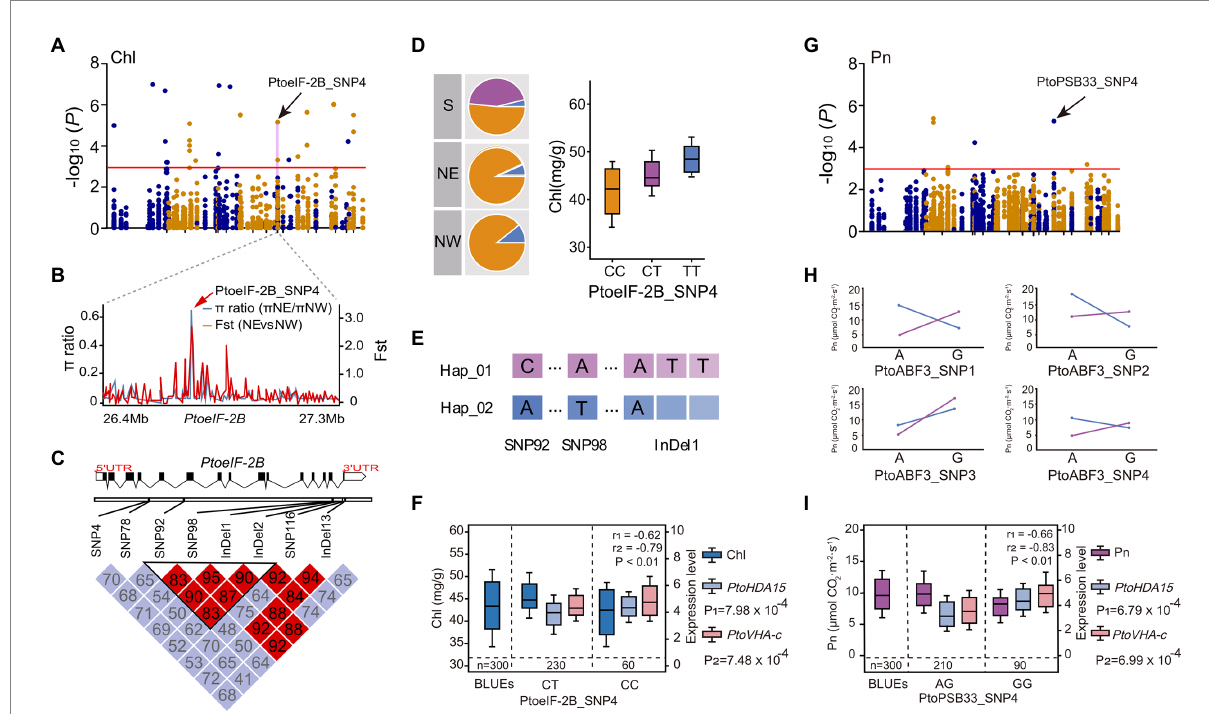
FIGURE 4 PtoPSB33 and PtoeIF-2B are implicated in the response to drought stress in P. tomentosa . (A) Manhattan plot for Chl. (B) Identification of the selection sweep signature of PtoeIF-2B_SNP4. (C) The genome structure and haplotype block of PtoeIF-2B gene. (D) Genotypic frequencies of significant SNP of PtoeIF-2B among the three regions. (E) Three significant loci detected by single-gene association analysis, which constituted a conserved haplotype. (F) Box plots for Chl (dark-blue), PtoHDA15 expression (blue) and PtoVHA-c expression (pink) plotted as an effect of genotype at PtoeIF-2B_SNP4. (G) Manhattan plot for Pn marked with the focal SNP of PtoPSB33_SNP4. (H) The epistatic effects of PtoPSB33_ SNP4 with four SNPs in PtoABF3 . (I) Box plots for Pn (purple), PtoHDA15 expression (blue) and PtoVHA-c expression (pink) plotted as an effect of genotype at